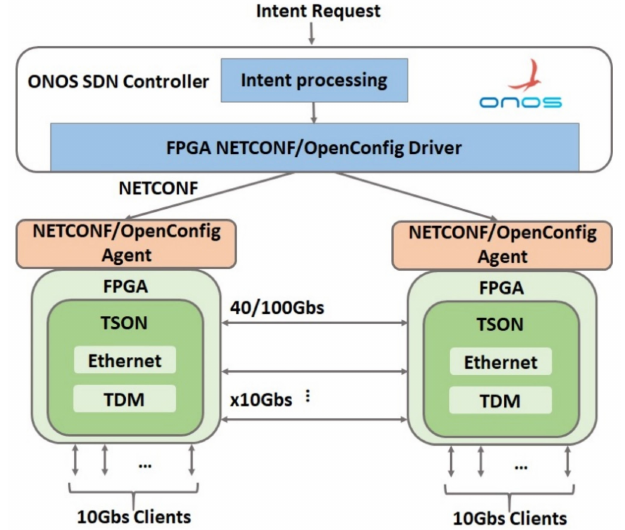
Figure 17. The TSON control plane architecture. FPGA: field-programmable gate array. SDN: software- defined networking, NETCONF: network configuration protocol, TDM: time domain